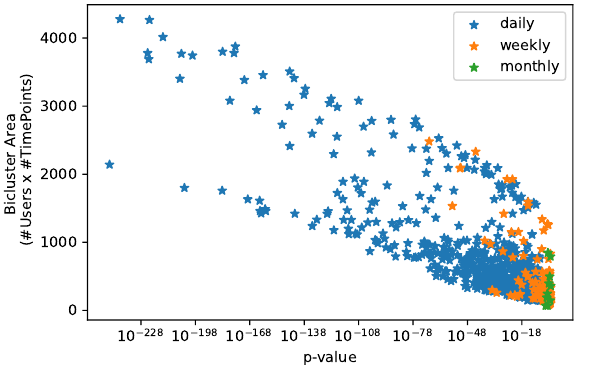
Figure 26. Statistical significance vs. size of biclusters found assuming constant patterns at In- fraQuinta,